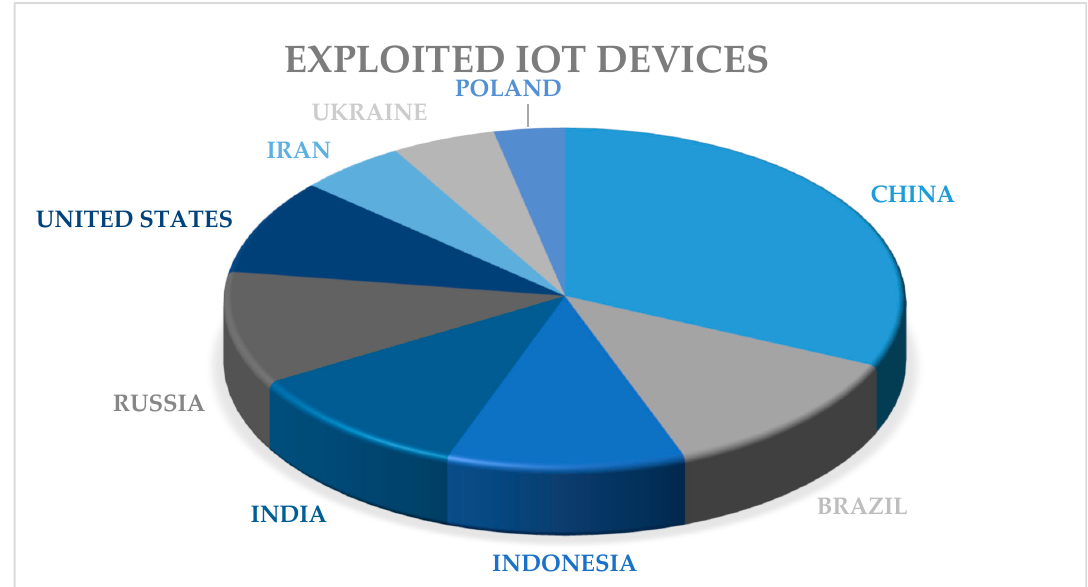
Figure 2. Distribution of Exploited IoT Devices [11].